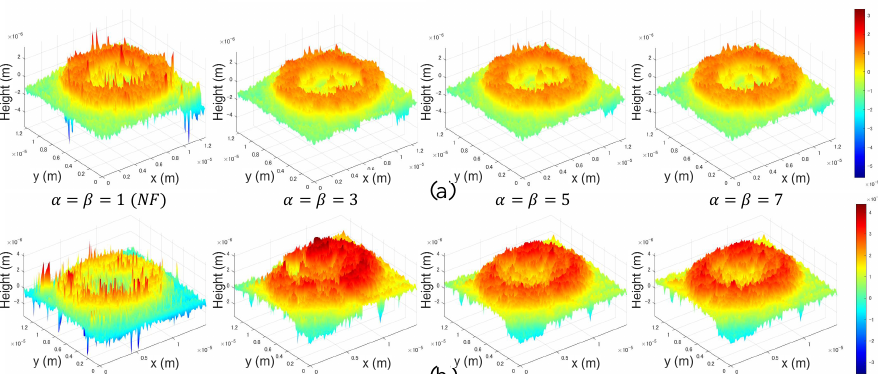
Figure 9. Results by WiSA for the red blood cells (RBCs) 3D profile. ( a ) 3D profile without huge noise and ( b ) 3D profile with huge